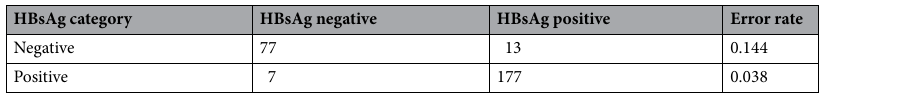
Table 3. HBsAg immunoassay results classification error rate on test data for all patient cohort analysed by random forest (overall error rate = 7.30%). Table supports the results presented in Fig. 2. The top four predictor variables were used for the calculation of error